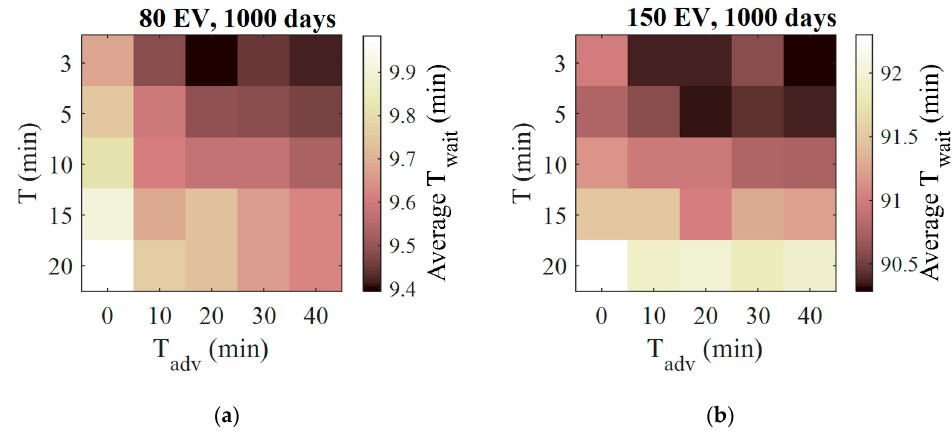
Figure 12. Evolution of average T wait as a function of T and T adv for ( a ) 80 and ( b ) 150 EV.